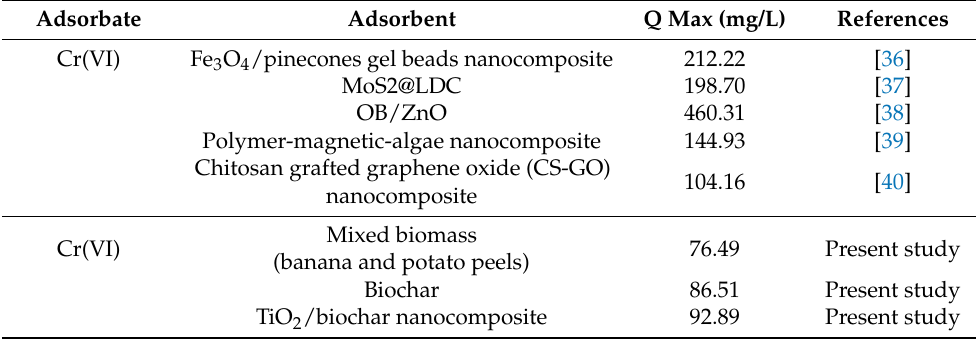
Figure 7. Comparison of adsorption efficiency by prepared adsorbents. Q max results obtained in this work and compared with others reported in the litera- ture, for the same adsorbate, are represented in Table 2. Table 2. Comparison of adsorption efficiency of different adsorbents.